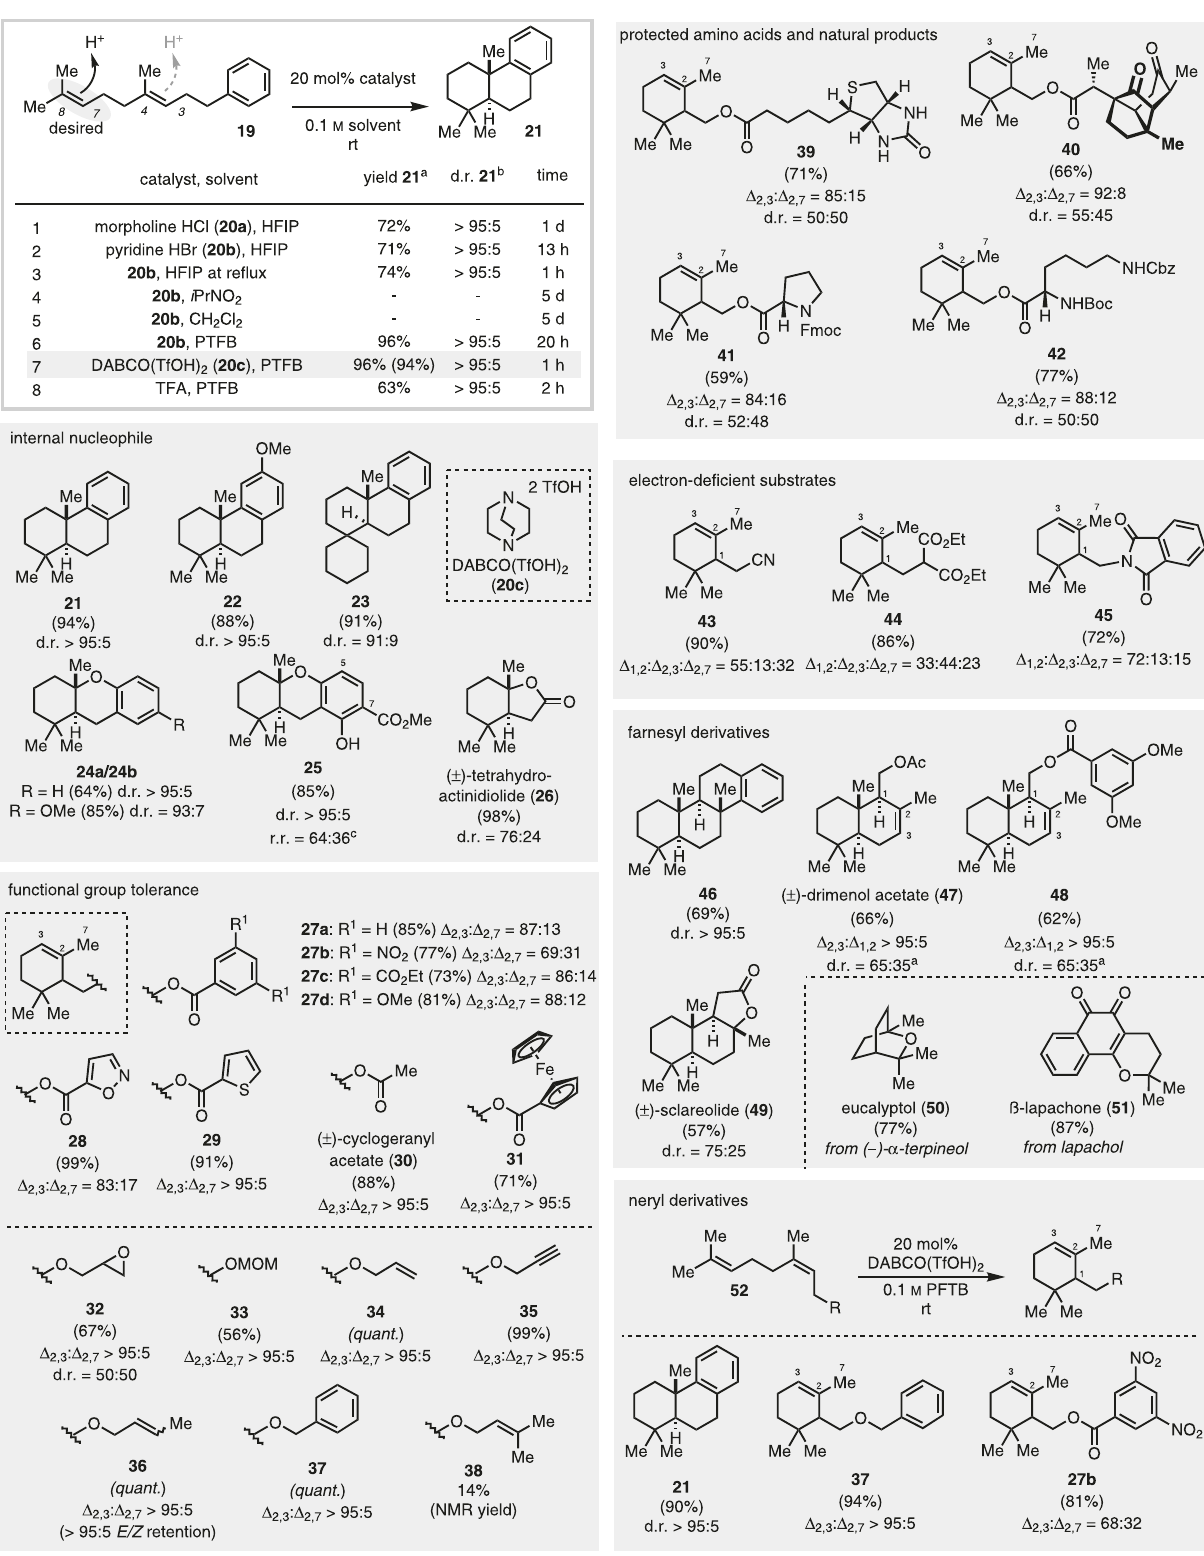
internal standard. Isolated yields are in parentheses. b The diastereomeric ratio (d. r.) was determined by GC-FID or GC-MS. d.r. at C 1. c r. r. refers to C 7: C 5 CO 2